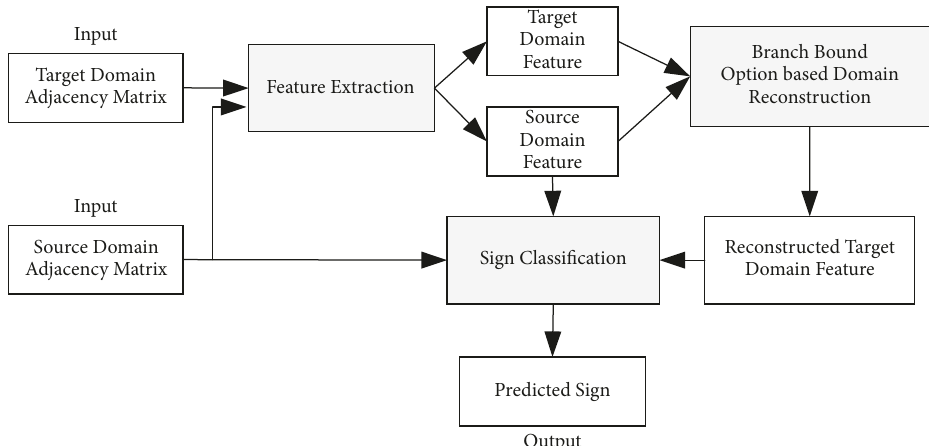
Figure 2: The architecture of the proposed SP BBTL